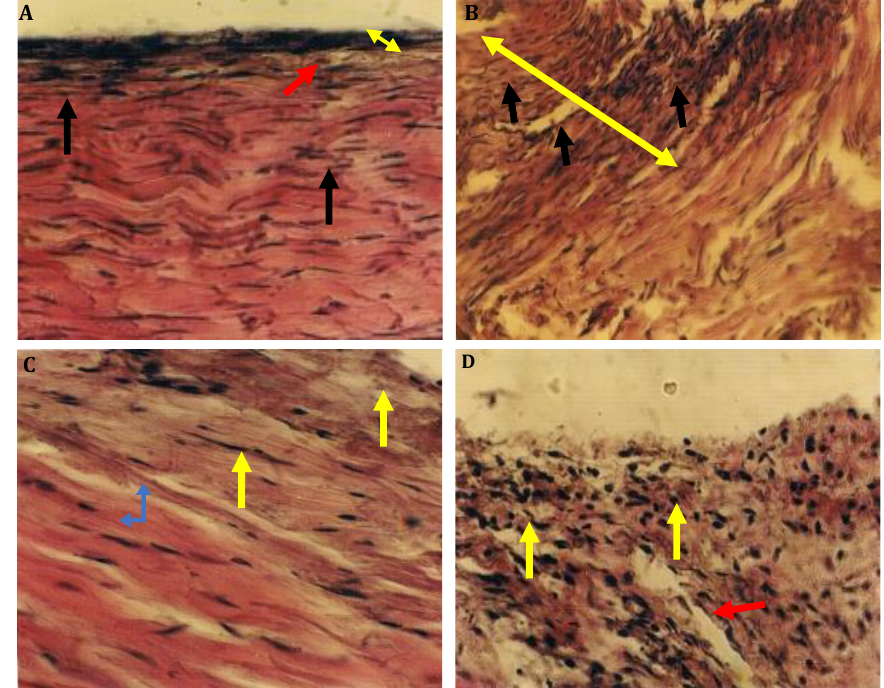
Figure 4 . Representative sections of injured semimembranosus muscle tendon of local rabbit on 8th postoperative day in (A) Control group showing thin epitenon (yellow double-arrow), hemorrhage (red arrows), light infiltration of inflammatory and fibroblast cells (black arrows), H&E, 40×; (B) Group A , irradiated with diode impulse laser at 1800 rad for 15 min showing thick epitenon (yellow double-arrow), severe infiltration of inflammatory and fibroblast cells (black arrows), H&E, 20×; (C) Group B , irradiated with diode impulse laser at 3000 rad for 25 min showing severe infiltration of inflammatory and fibroblast cells (yellow arrows) and new blood vessels (red arrow), H&E, 40×; (D) Group D , irradiated with diode impulse laser at 4200 rad for 35 min showing mild infiltration of inflammatory cells (yellow arrows), regular collagen fibers (blue left-up arrow), H&E,